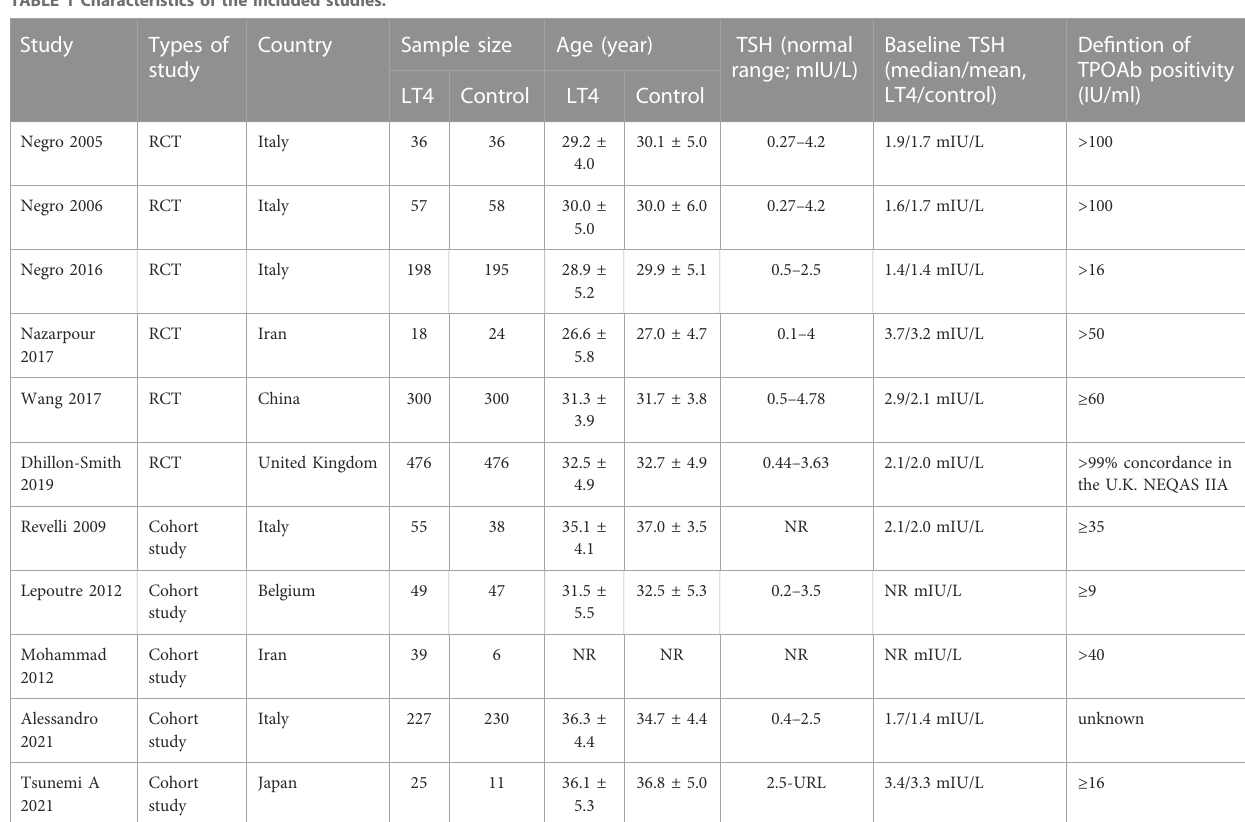
TABLE 1 Characteristics of the included